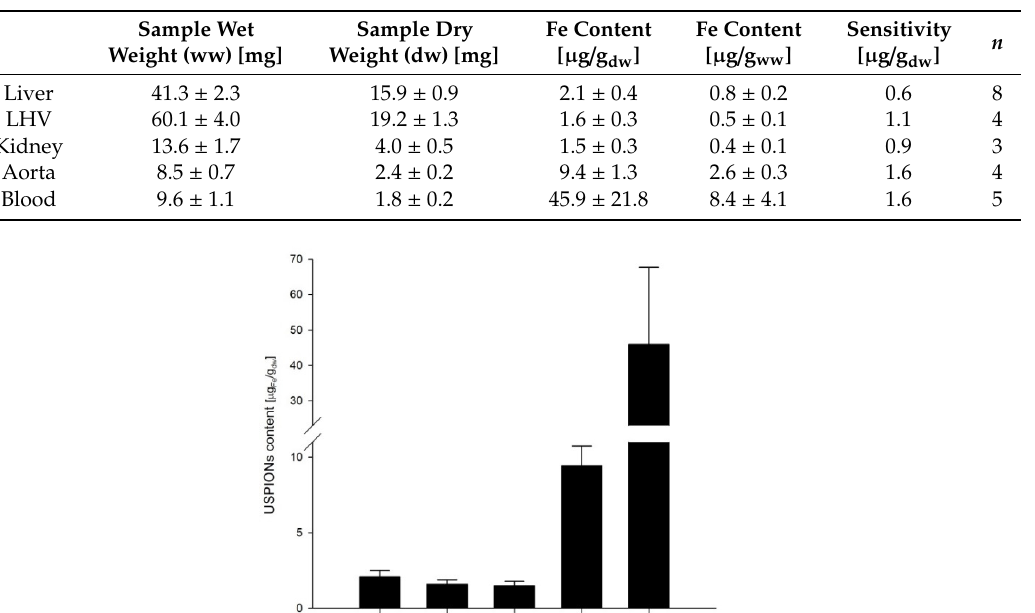
( b ) Figure 15. Magnetic properties of the blood of control and USPION-treated rats. ( a ) The partial M ( H ) dependences at 300 K and ( b ) corresponding M ’ data for individual rats of the USPION treated group after subtraction of the control group average (b). Data (a) are presented as the averaged curve from the control group ( n = 4) and USPION-treated group ( n = 6). The mass of dry samples was in the range of 1.3–2.3 mg. From measurements of M of the control groups, we derived the sensitivity of our method of determination of USPION-originated iron content as a variance of measurement changes with the magnetic field (Figure 16). Therefore, a line to the data was fitted by the weighted regression. In particular, we supposed 𝑣𝑎𝑟(𝜖 (cid:3036) ) = 𝜎 (cid:2870) 𝑥 (cid:2870) , i.e., the weights 𝑤 (cid:3036) = 1 𝑥 (cid:3036)(cid:2870) ⁄ . Then, a confidence band around the fitted line 𝑦(cid:3548) is determined as 𝑦(cid:3548) ± 2𝜎(cid:3548)𝑥